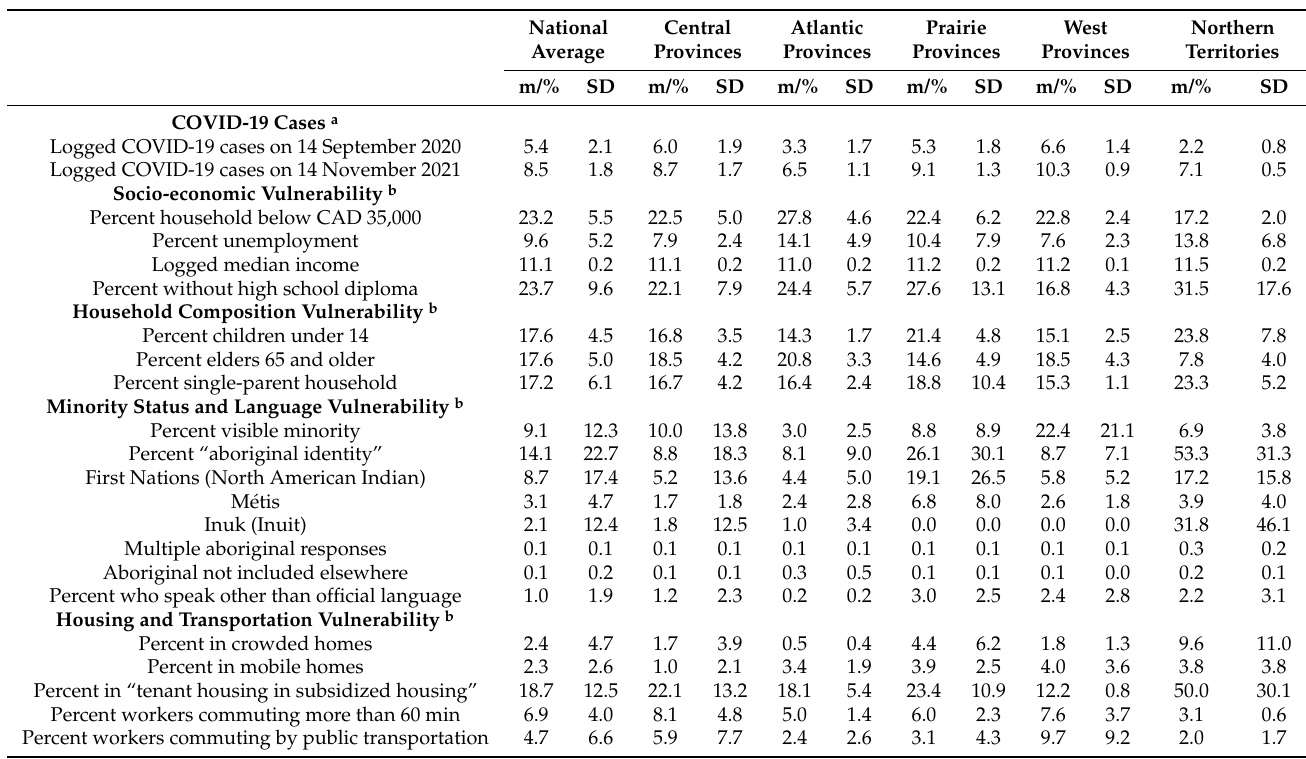
Table 1. Descriptive Statistics for Health Regions by National Average and Province/Territory.